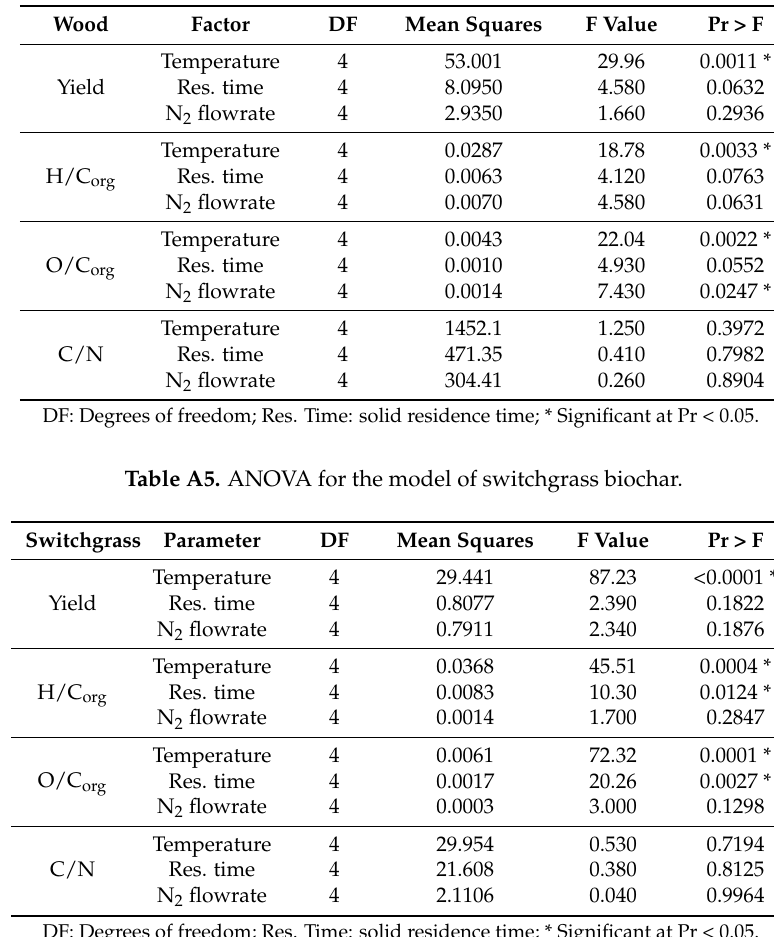
Table A4. ANOVA for the model of wood biochar.